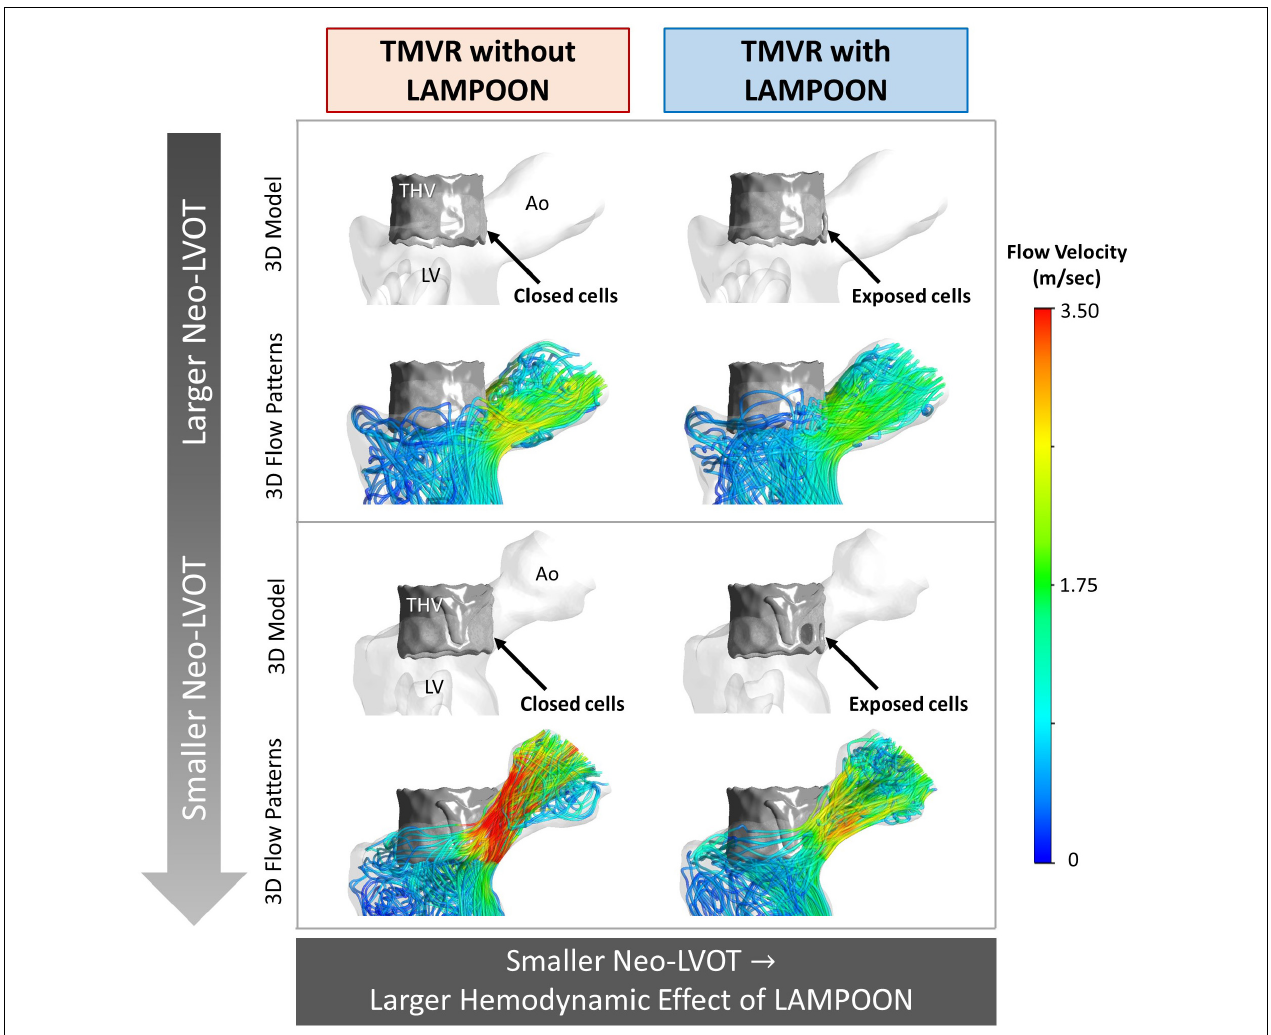
FIGURE 6 | Flow simulations demonstrating the relationship between neo-LVOT size and LAMPOON efficacy. Two representative subjects are shown, where the subject shown in the top panel (Subject 6) has a larger neo-LVOT area as compared to the subject shown in the bottom panel (Subject 7). 3D models and simulated flow patterns are shown for the conditions of TMVR with and without LAMPOON. As neo-LVOT area decreases, the hemodynamic effect of LAMPOON increases. The total area of the transcatheter valve cells exposed by the splayed anterior leaflet were identical in both subjects (88 mm 2 ). Ao, aorta; LV, left ventricle; neo-LVOT, neo-left ventricular outflow tract; THV, transcatheter heart